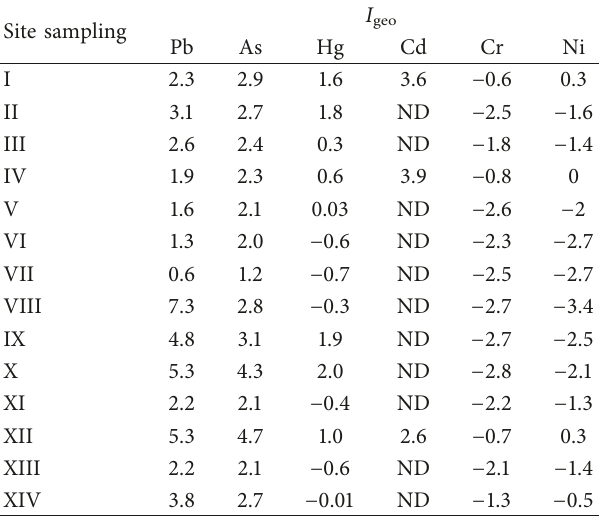
Table 5: Geoaccumulation Index ( I geo ) values of heavy metals of soils and sediments from the different sampling sites of the La Zacatecana Lagoon.